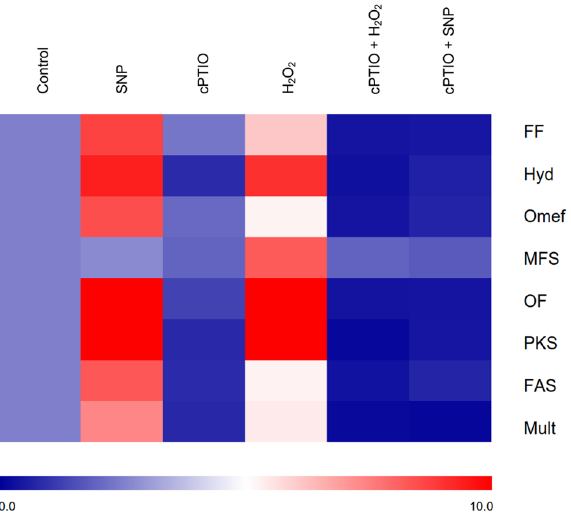
Figure 6. The transcriptional activities of HA biosynthetic genes in different treatments. FF: FAD/FMN- dependent oxidoreductase, Hyd: Hydroxylase, Omef: O-methyltransferase, MFS: Major facilitator superfamily (MFS) transporter, OF: O-methyltransferase/FAD-dependent monooxygenase, PKS: Polyketide synthase, FAS: Fasciclin, Mult: Multicopper oxidase. The transcriptional level of control group was given an arbitrary value of 1. A color scale indicates the transcriptional activities of the different genes, from lowest (blue) to highest